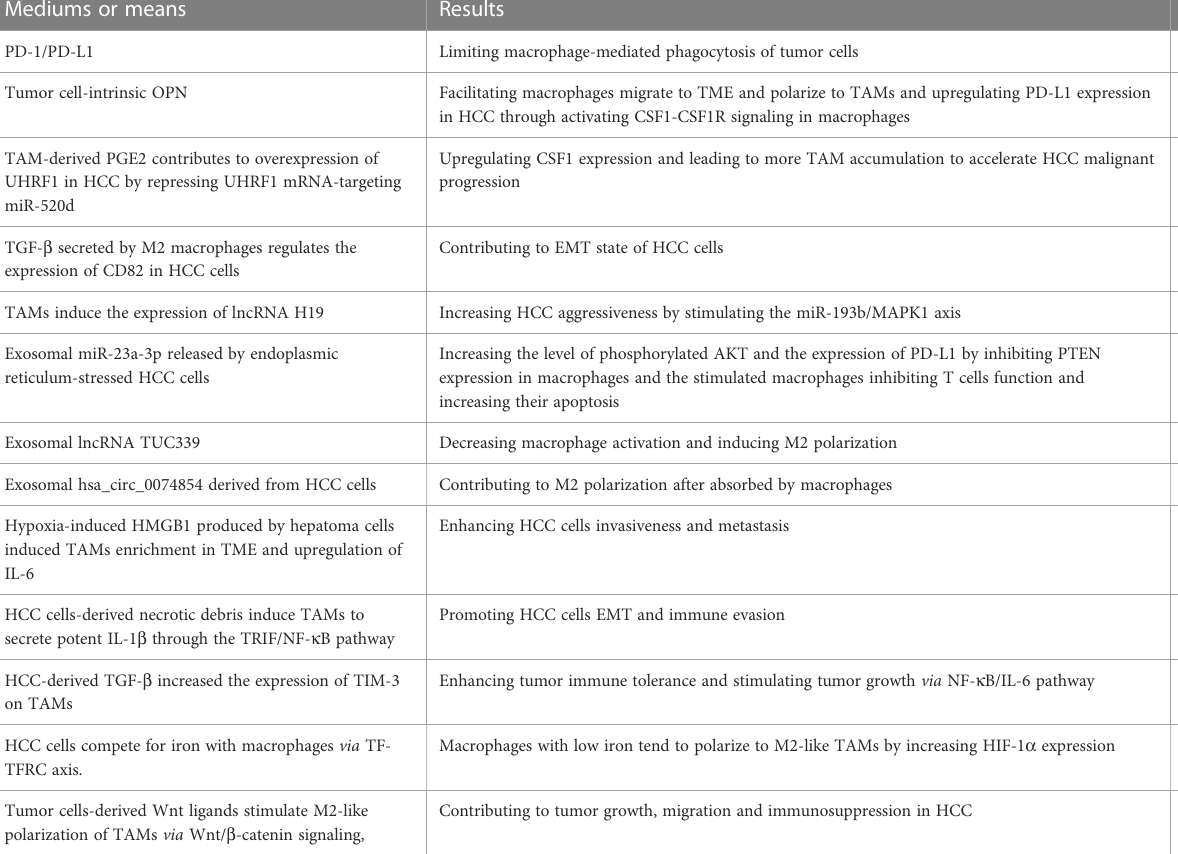
TABLE 2 The interaction between HCC cells and TAMs. Mediums or means